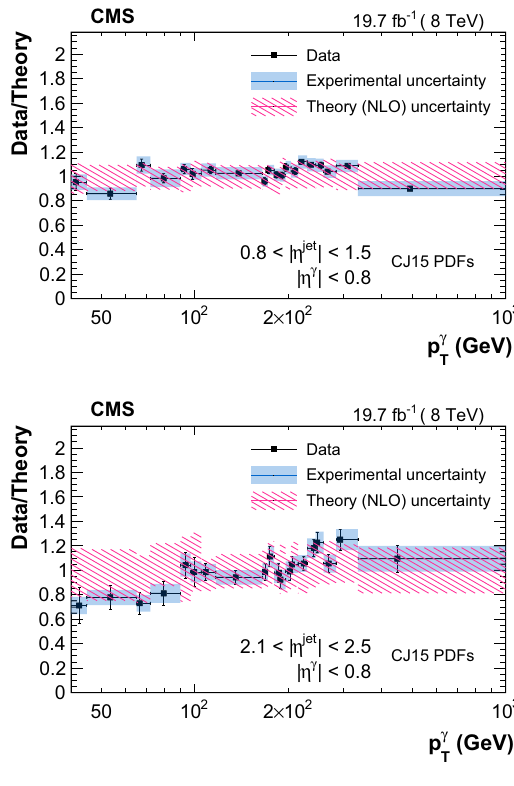
Fig. 5 Ratio of triple-differential cross sections as a function of p measured in data over the corresponding GamJet NLO theoretical pre- diction (obtained with the CJ15 PDFs) in different bins of | η jet | for